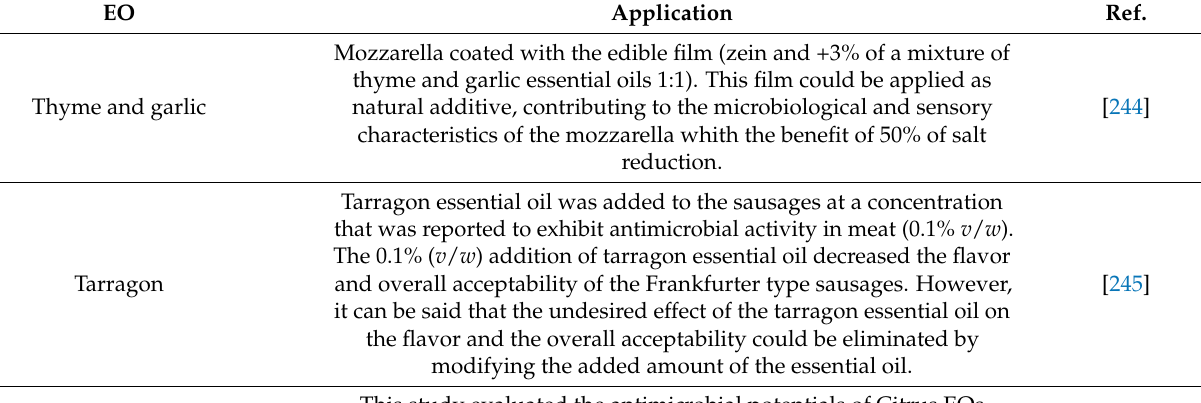
Table 3. Application of some EOs incorporated in films or coatings for food preservation and safety.